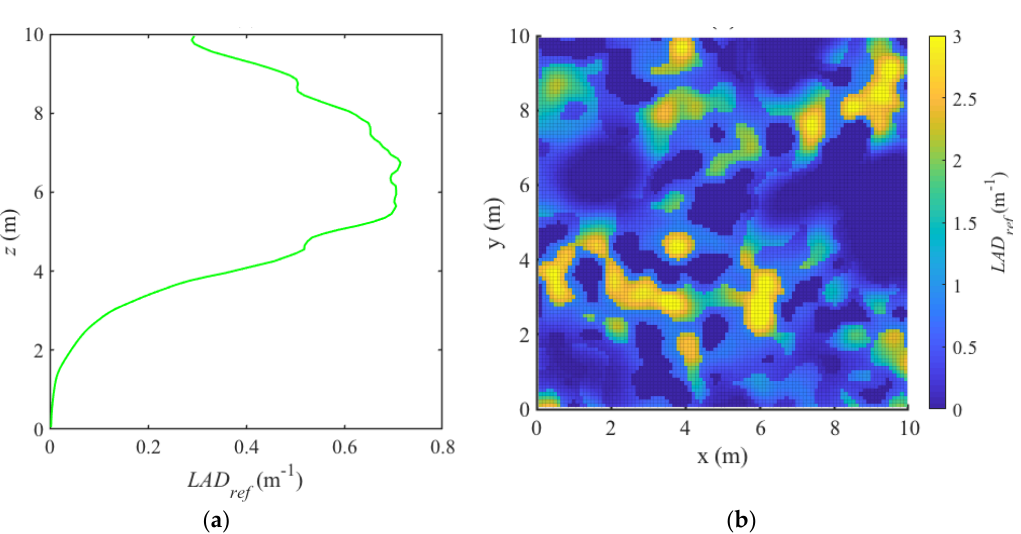
Figure A1. Reference vegetation: ( a ) vertical profile of 𝐿𝐴𝐷 𝑟𝑒𝑓 ; ( b ) horizontal distribution of 𝐿𝐴𝐷 𝑟𝑒𝑓 at z =6 m.